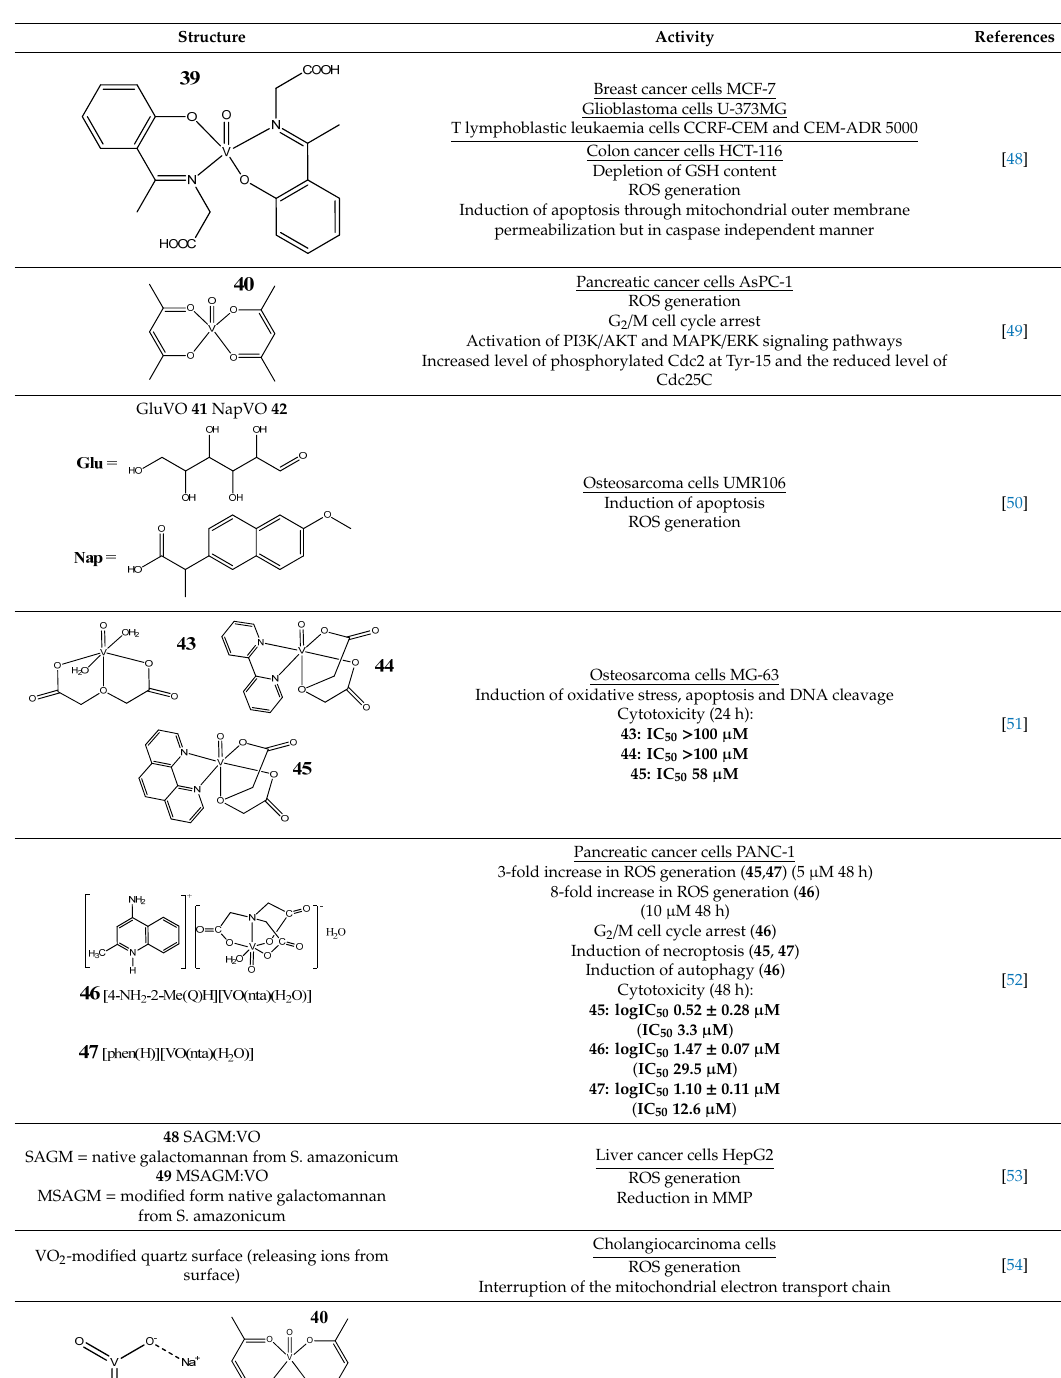
48 SAGM:VO SAGM = native galactomannan from S. amazonicum 49 MSAGM:VO MSAGM = modified form native galactomannan from S.